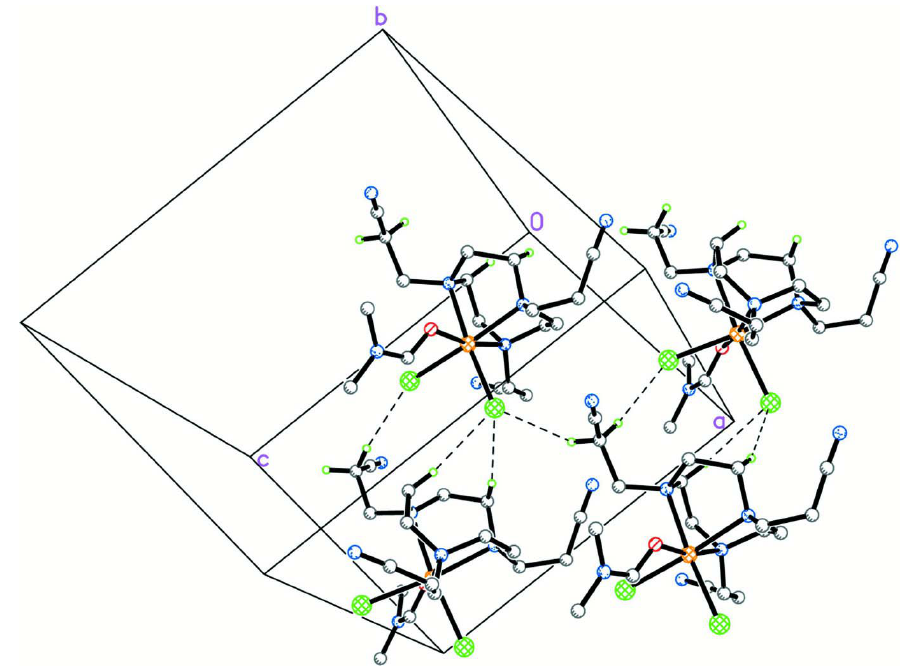
Figure 2 Partial packing diagram of the title compound, showing the two-dimensional network formed through intermolecular C— H···Cl hydrogen bonds (dashed lines). For clarity, H atoms not involved in hydrogen bonding have been